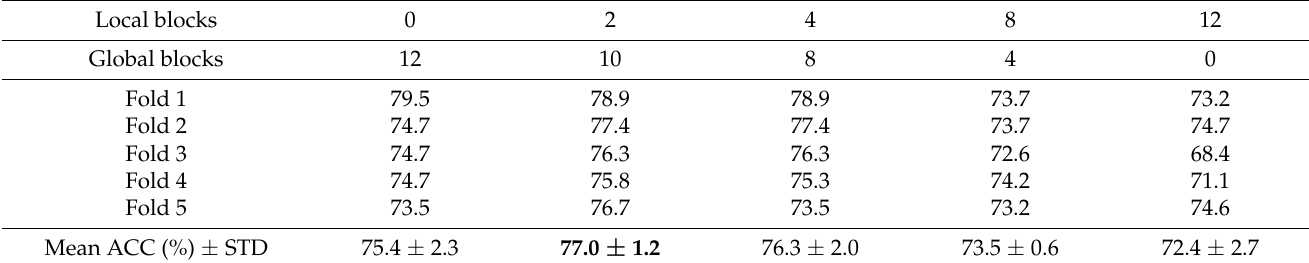
Table 1. Summary of model-generated case classification accuracy (ACC) along with the standard deviation (STD) in five-fold cross-validation on the unregistered, four-view mammogram dataset (LCC, RCC, LMLO, RMLO), with different numbers of local and global transformer blocks (using a small DeiT model).